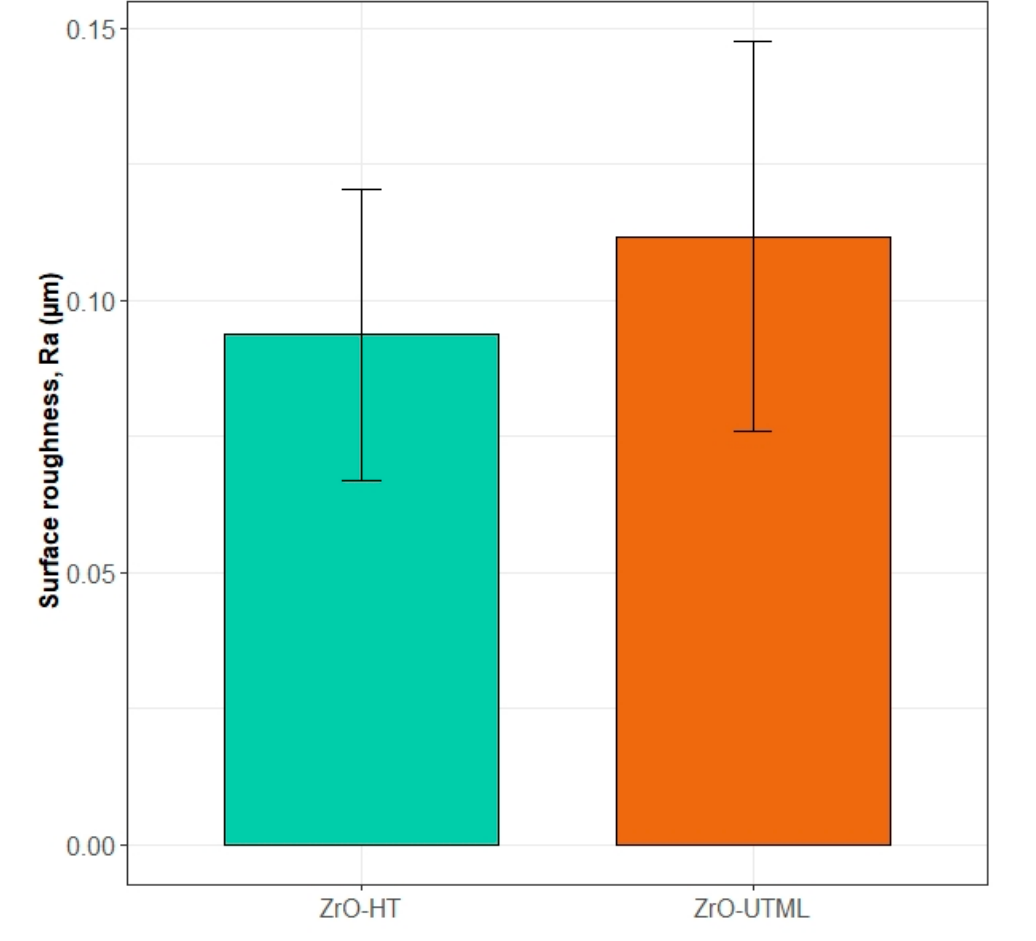
Figure 4. Surface roughness of the two materials included in the study.